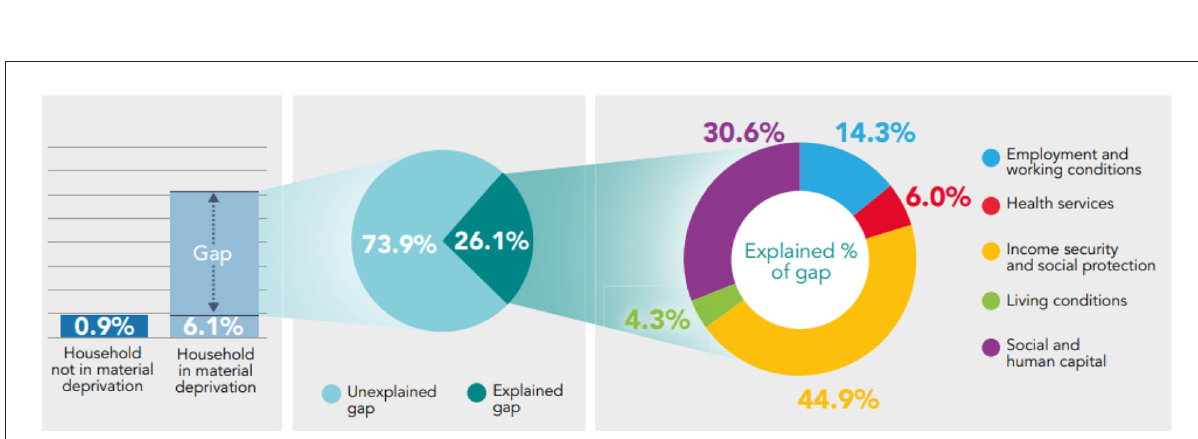
FIGURE6 Decomposing the gap in prevalence of low life satisfaction between those who report being in material deprivation and those who do not using the Binder-Oaxaca methodology, persons aged 16 + , Wales, 2016–17 to